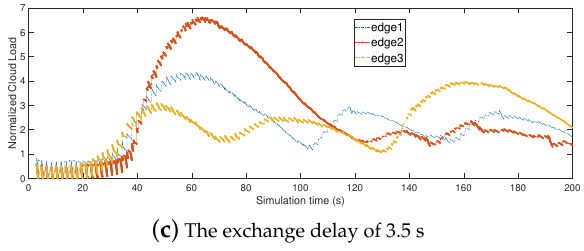
Figure 10. The convergence speed incurred by information exchange